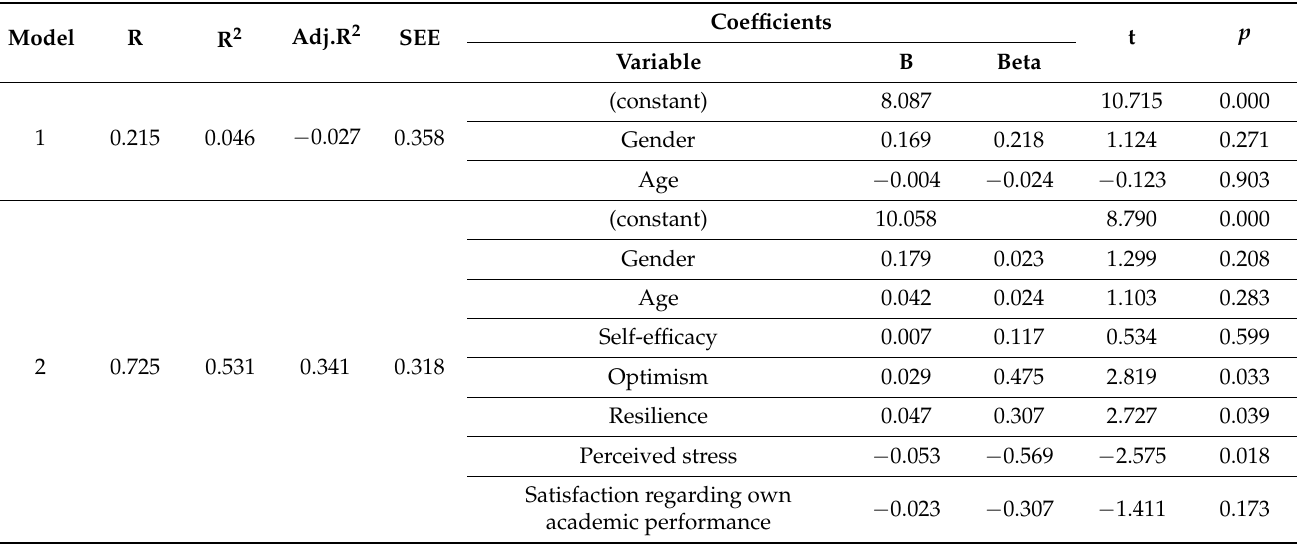
Table 2. Determinants of academic performance for students in the lower GPA quartile. (GPA < 8.32) ( N = 22) (linear regression).